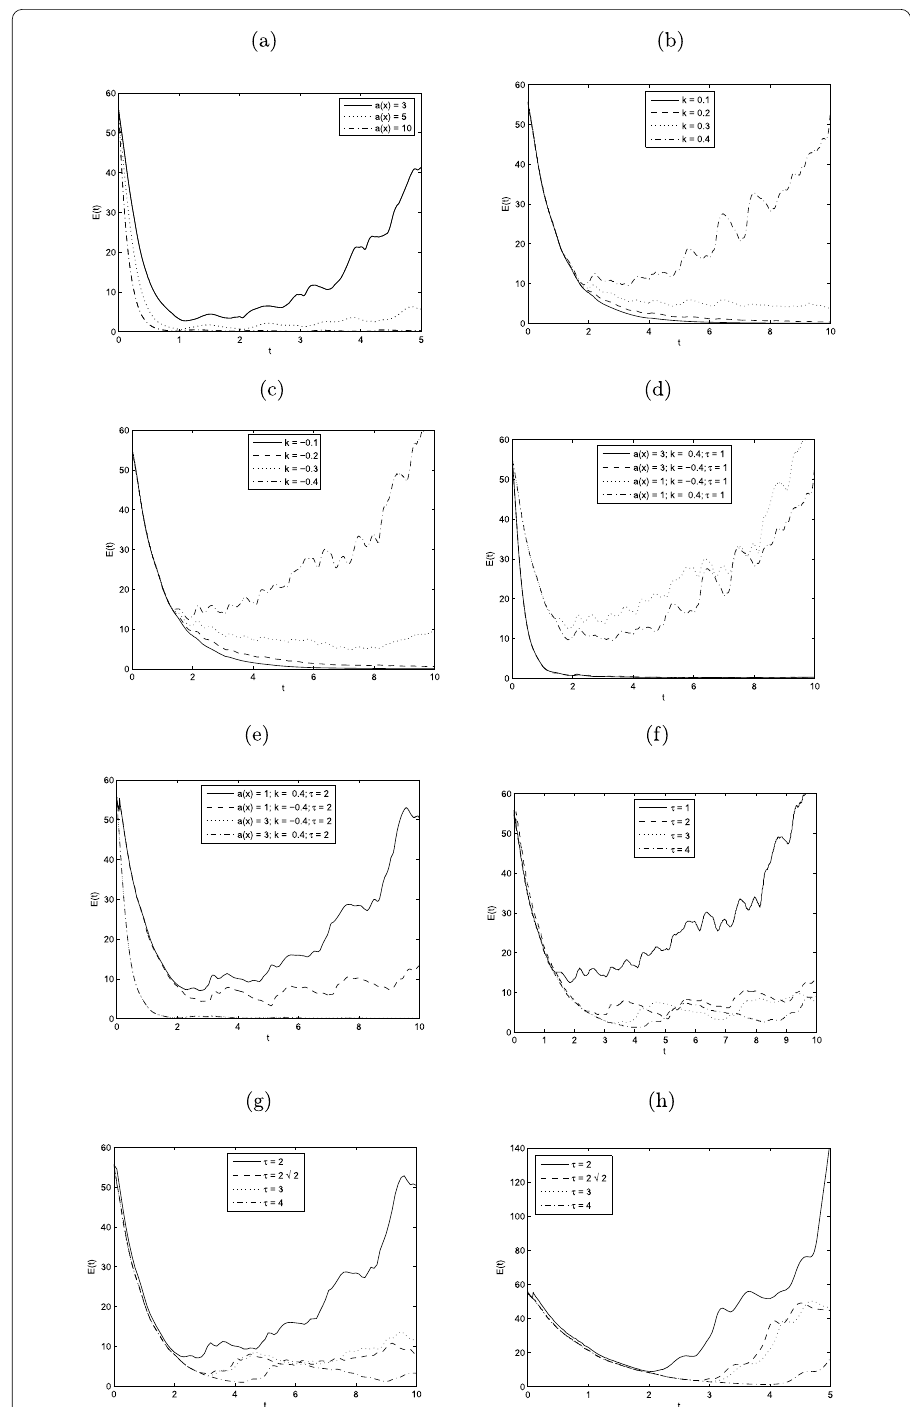
Figure 15 The energy E ( t ) of the wave system (1.16)-(1.20) with: a) τ = 1 when k = 1, and for different functions a ( x ); b) τ = 1, k is positive and when a ( x ) = 1; c) τ = 1, k is negative and when a ( x ) = 1; d) τ = 1, a ( x ) = 1 and a ( x ) = 3, and for numerous values of k ; e) τ = 1, a ( x ) = 1 and a ( x ) = 3, and for several values of k ; f) different delays when a ( x ) = 1 and for k = –0.4; g) various delays when a ( x ) = 1 and for k = 0.4; h) different delays when a ( x ) = 1 and for k =